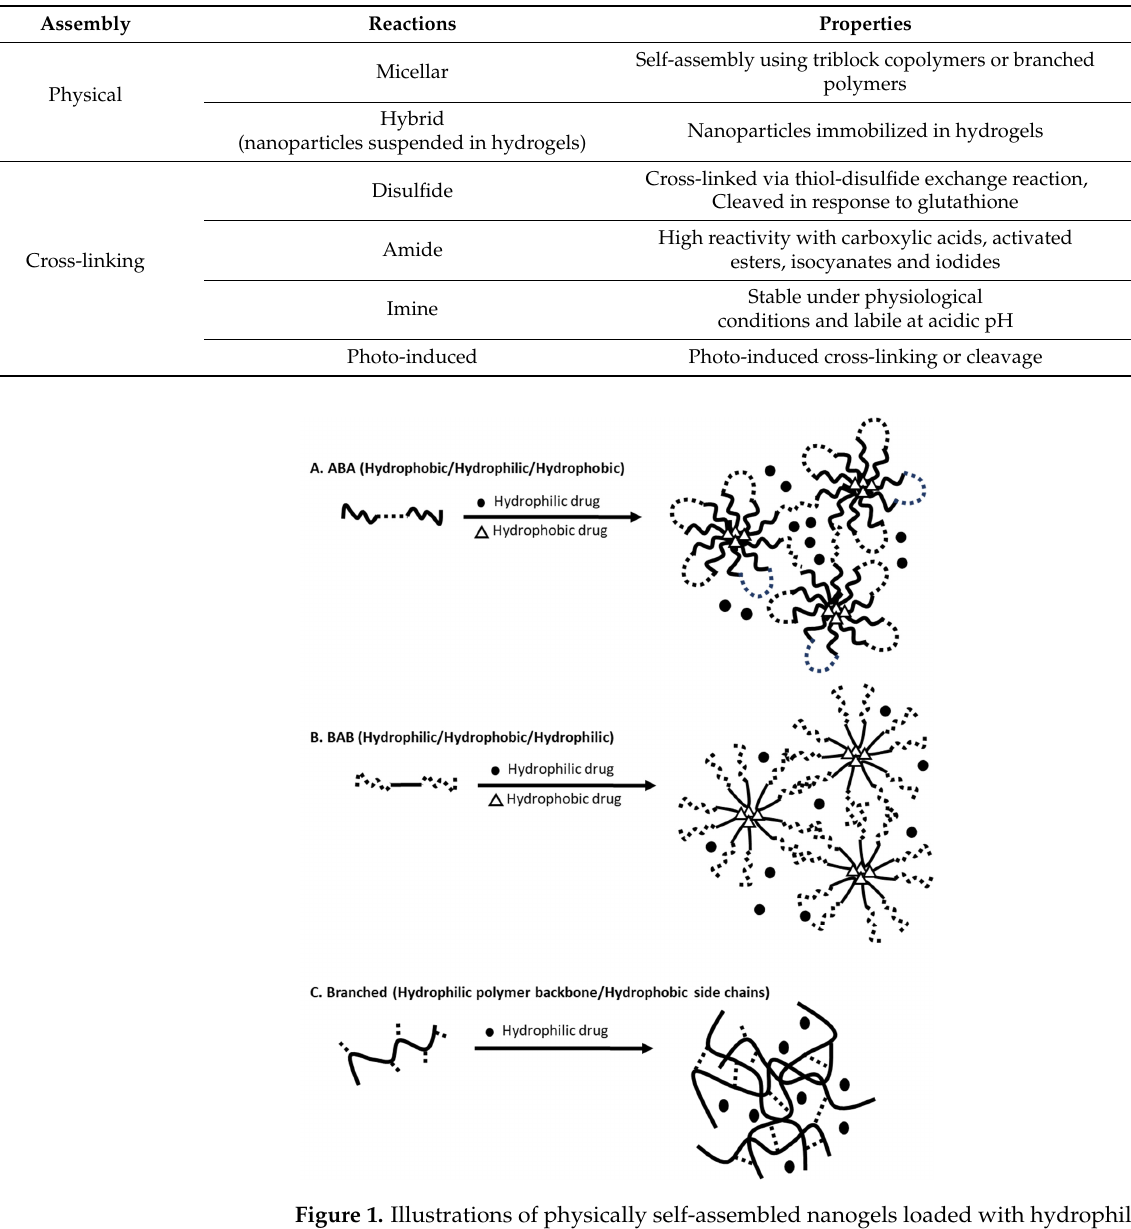
Table 1. Main nanogel assembly techniques.